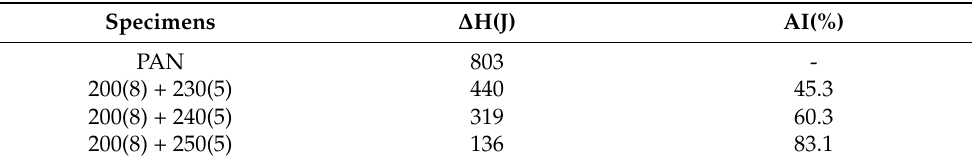
Table 2. The aromatic index of specimens under several processing conditions from DSC results.